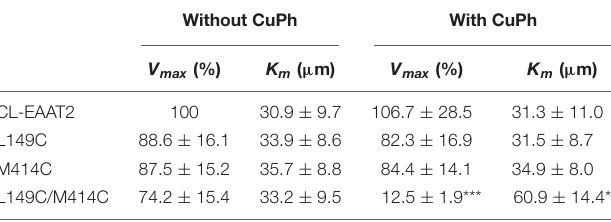
TABLE 1 | Kinetic parameters of EAAT2 mutants in the absence or presence of CuPh. Without CuPh With